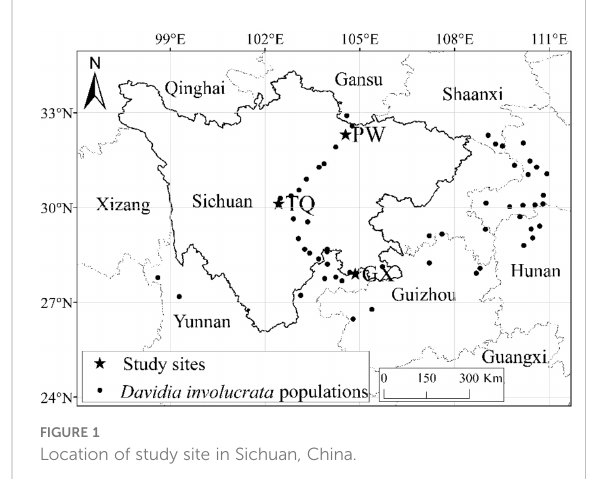
FIGURE 1 Location of study site in Sichuan,